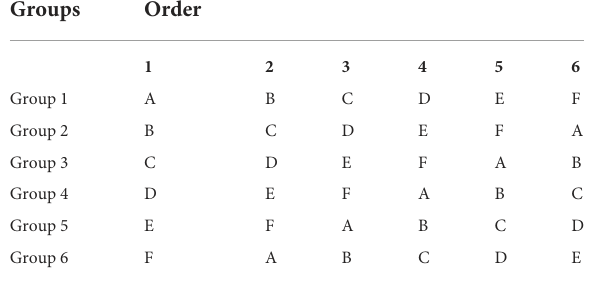
TABLE 3 Latin square design.